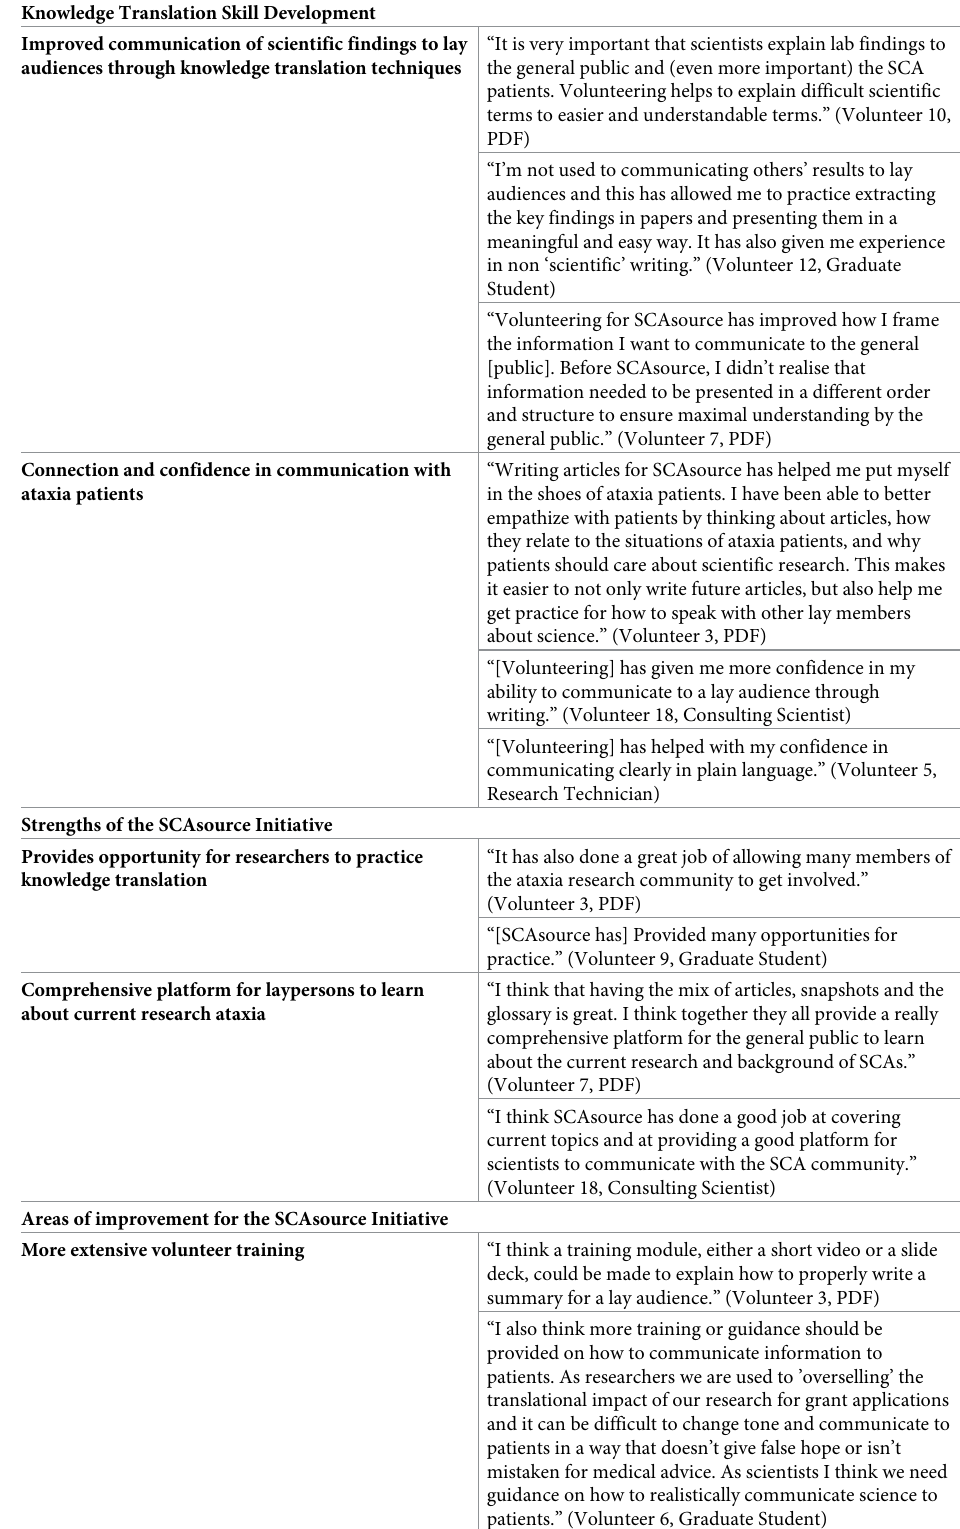
Table 3. Volunteer themes and representative